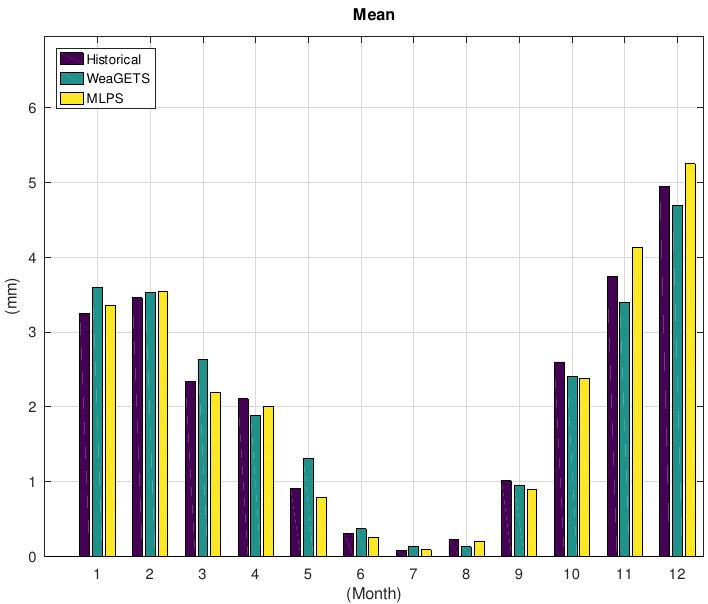
Figure 9. Monthly mean of the synthetic (WeaGETS and MLPS) and historical time series of the Gibraltar weather station.